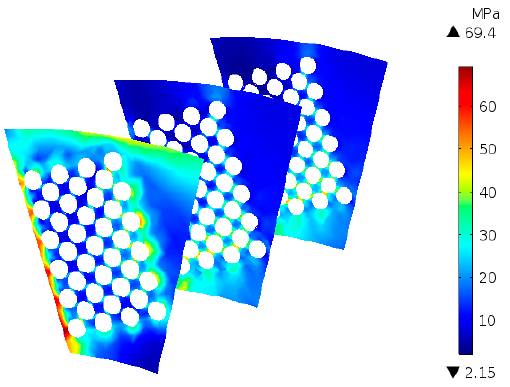
Figure 5. The von-Mises stress distribution in the epoxy at three different axial positions: 0, l /2 and l.